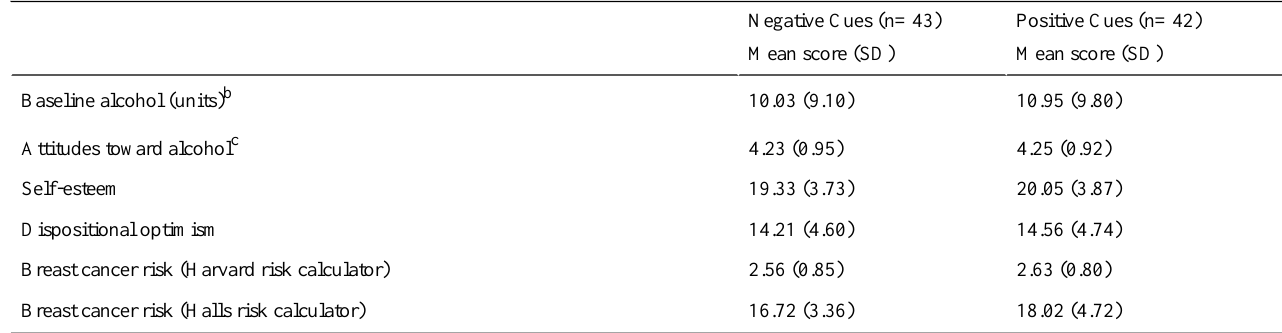
Table 1. Mean pre-manipulation measures by condition group